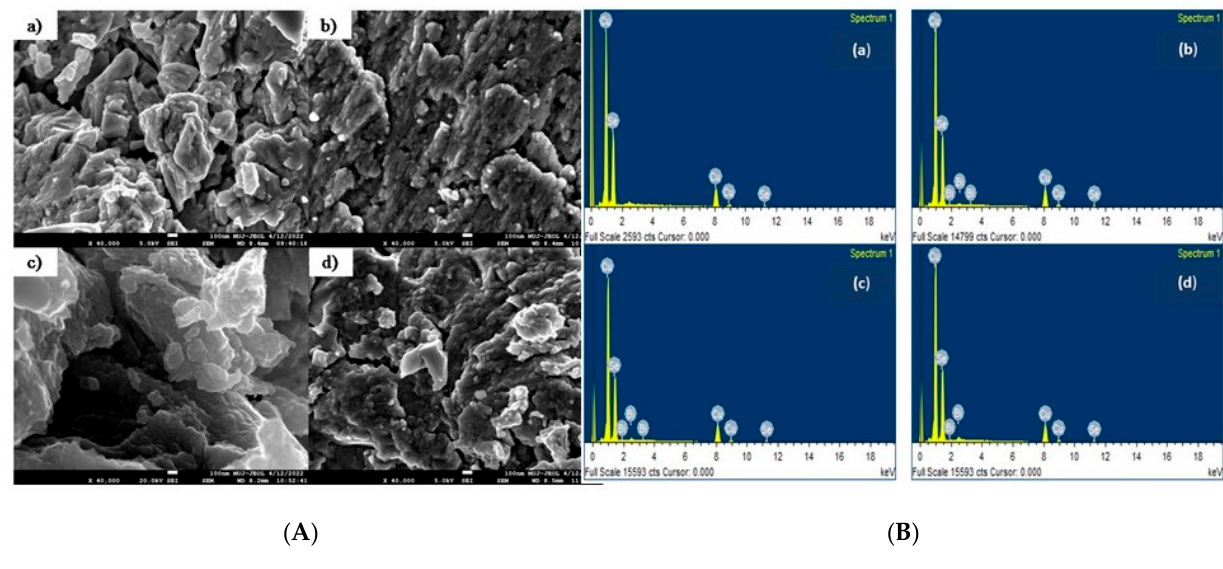
Figure 5. ( A ) SEM images of ( a ) Cu 2 Se, ( b ) Cu 1.996 Bi 0.004 Se, ( c ) Cu 1.992 Bi 0.008 Se, ( d ) Cu 1.988 Bi 0.012 Se samples. ( B ) EDS spectrum of ( a ) Cu 2 Se, ( b ) Cu 1.996 Bi 0.004 Se, ( c ) Cu 1.992 Bi 0.008 Se, ( d ) Cu 1.988 Bi 0.012 Se samples.